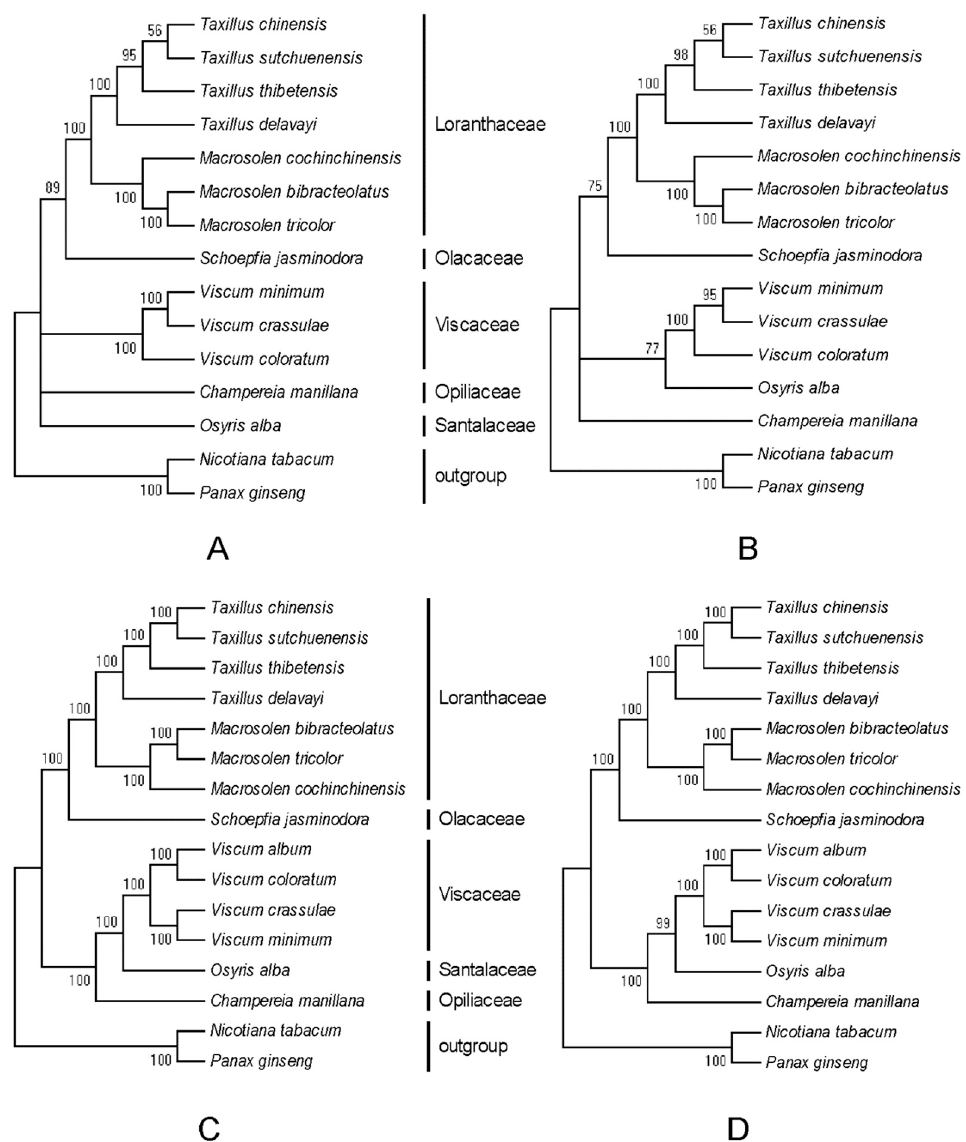
Figure 8. Phylogenetic trees constructed with the matK genes of 15 species by using the maximum parsimony (MP) ( A ) and maximum likelihood (ML) ( B ) methods. Phylogenetic trees constructed with 58 common protein-coding genes of 16 species using the MP ( C ) and ML ( D ) methods. Numbers at nodes are bootstrap values.